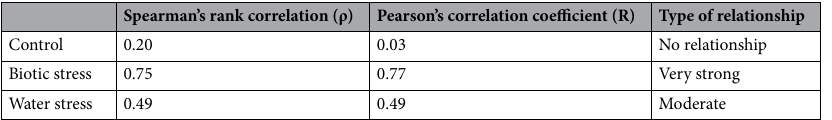
Spearman’s rank correlation (ρ) Pearson’s correlation coefficient (R) Type of